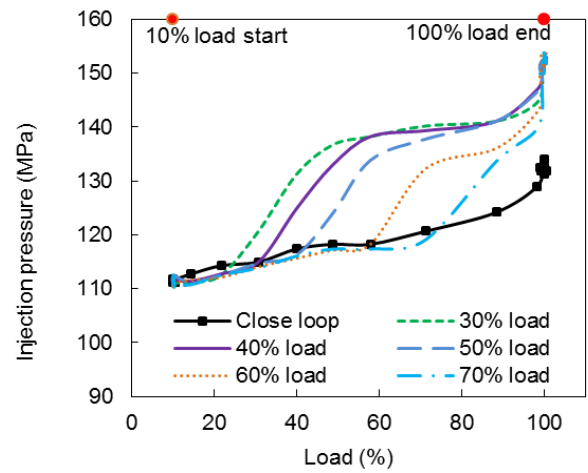
Figure 10. Test plan of sectional-stage rail pressure (SSRP) strategy.